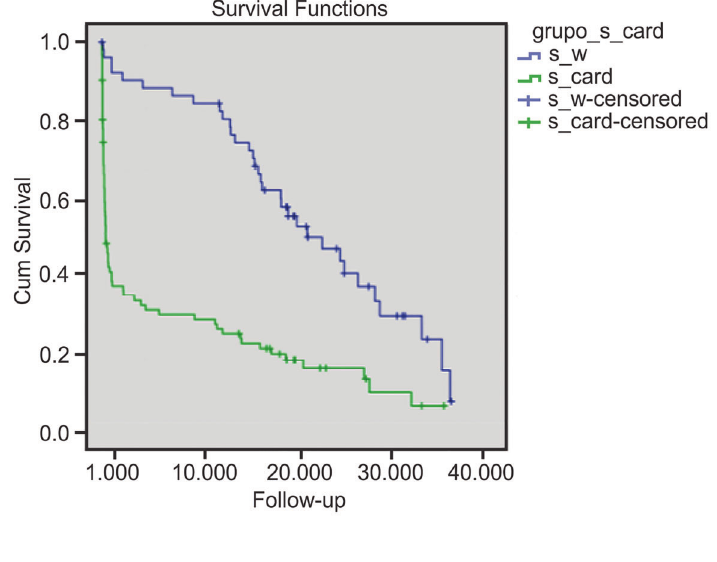
Figure 3. Primary outcome was a combination of death, unscheduled emergency room visit, and hospital readmission for any cause during follow-up. Cox cardiogenic syncope hazard ratio = 2.97 (1.94 – 4.55; P o 0.001).